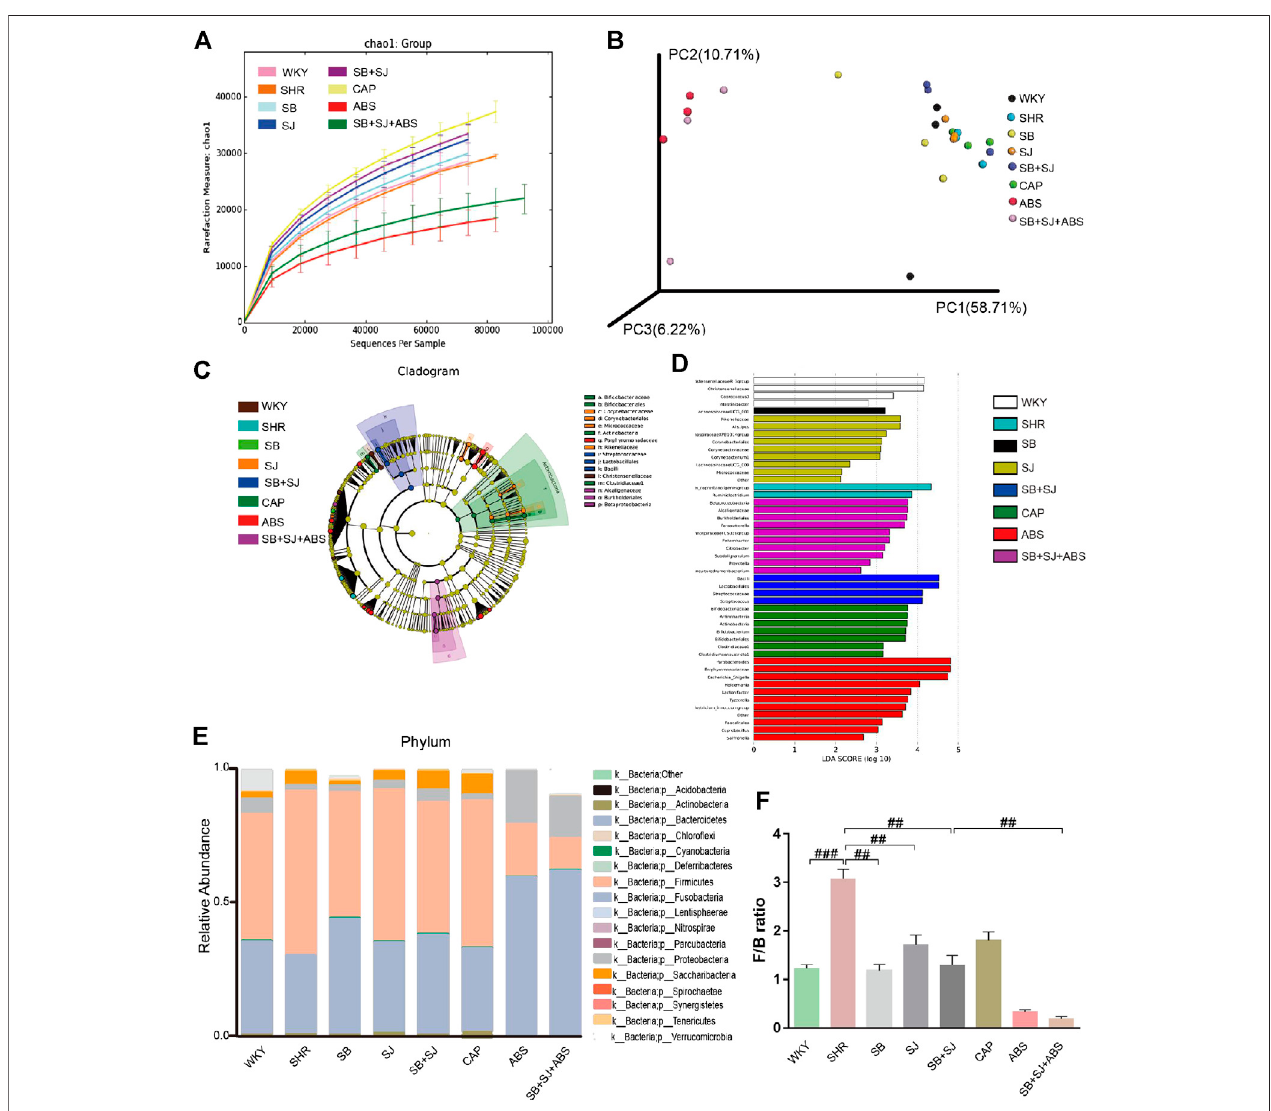
FIGURE3| Regulationofgutmicrobiotabytheco-treatmentofSBandSJinSHR. (A) ThealphadiversityevaluatedbyPDwholetree. (B) WeightedUniFrac-based PCoA analysis of the gut microbiome (beta diversity) via 16S rRNA sequencing. (C) Cladogram of LEfSe on the gut microbiome. (D) Bar diagram of LEfSe on the gut microbiome. (E) The phylum-level composition of the microbiota. (F) The Firmicutes/Bacteroidetes ratio. ### p < 0.001. ## p < 0.01. # p < 0.05.